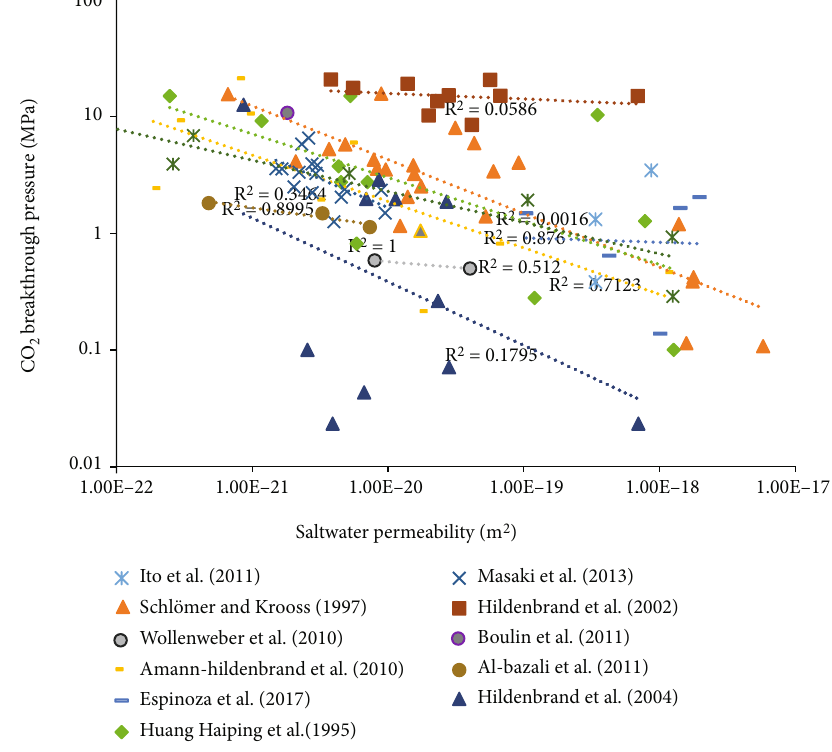
Figure 3: Relationship between saltwater permeability and breakthrough pressure of CO